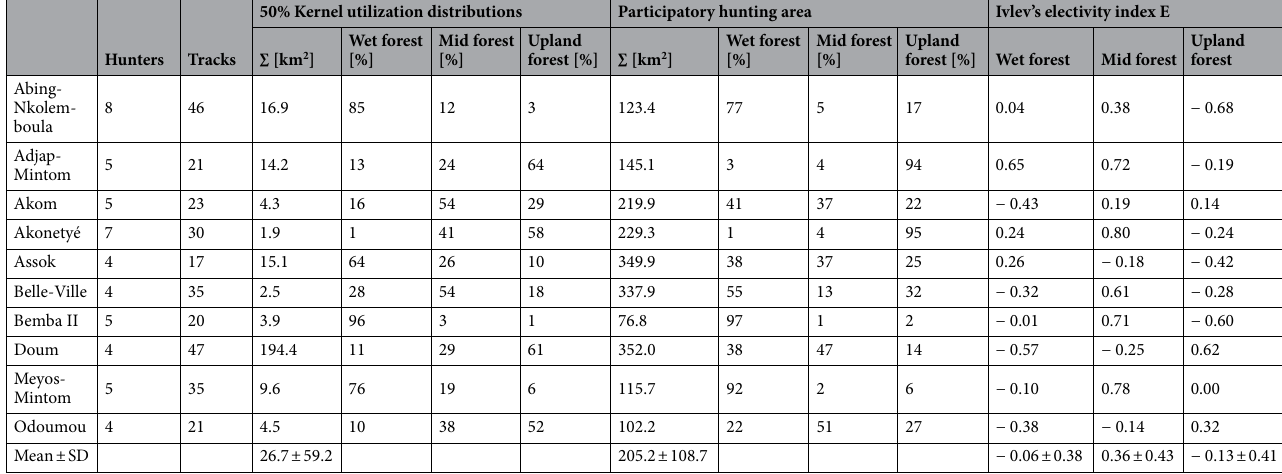
Table 2. Use of different habitat types during hunting sessions in 10 Baka villages.